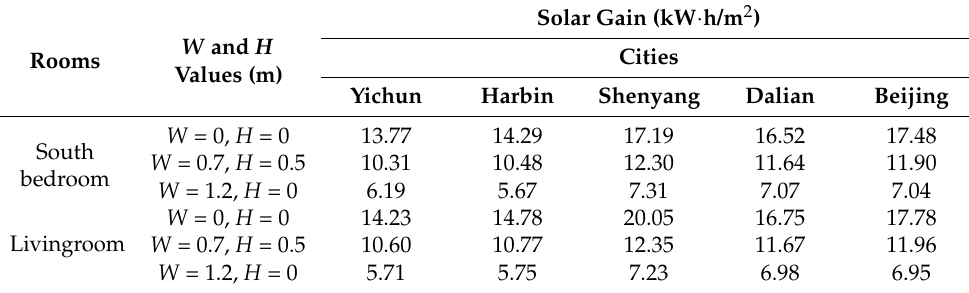
Table 13. Solar gain values of five representative cities from May to September.